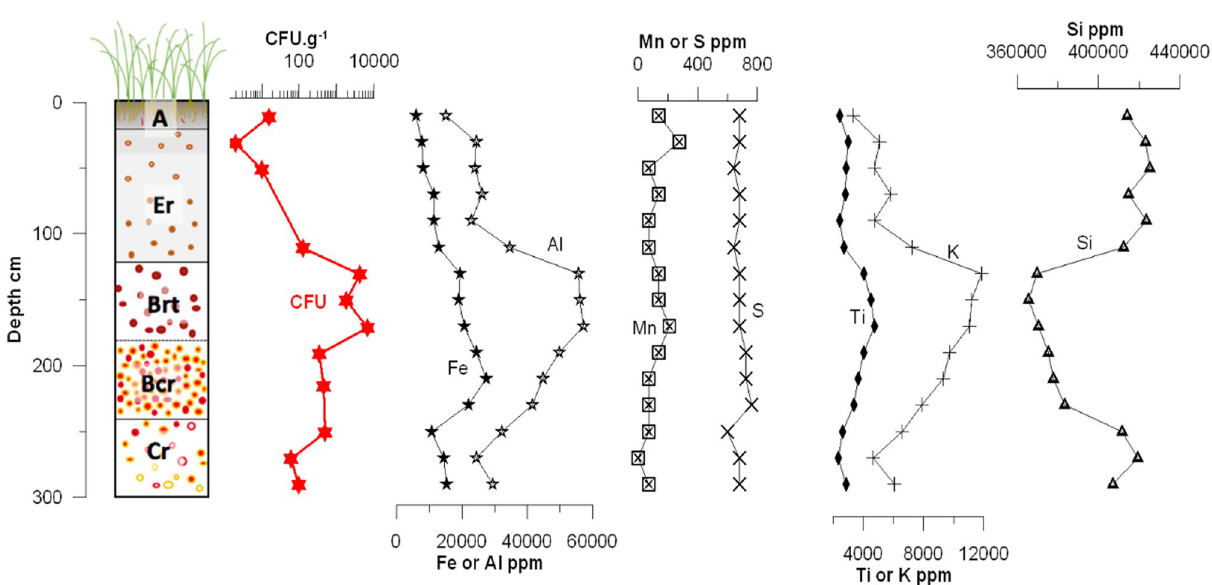
Figure 6. Soil log showing the main pedological horizons (i.e. A, Er, Brt, Bcr and Cr—see caption of Fig. 4 for meaning of abbreviations), semi-quantitative colony forming unit (CFU) counts of B. pseudomallei (CFU g −1 ), and elemental concentration along the 300-cm deep profile: iron (Fe), aluminum (Al), manganese (Mn), sulfur (S), titanium (Ti), potassium (K), silicium